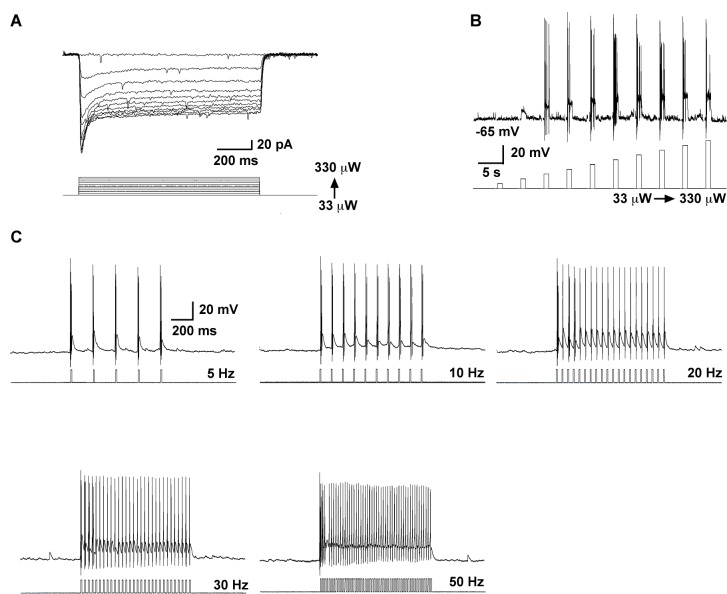
High fidelity response to light (470 nm) stimulation of ARH Kiss1 ChR2-expressing neurons.(A–B) Examples of evoked inward currents in voltage-clamp (A) and depolarization in current-clamp (B) with varied light intensity (33–330 µW). (C) Trains of light pulses (0.9 mW, 10 ms pulse-width) at various frequencies and the resulting action potentials in the same neuron from A and B.